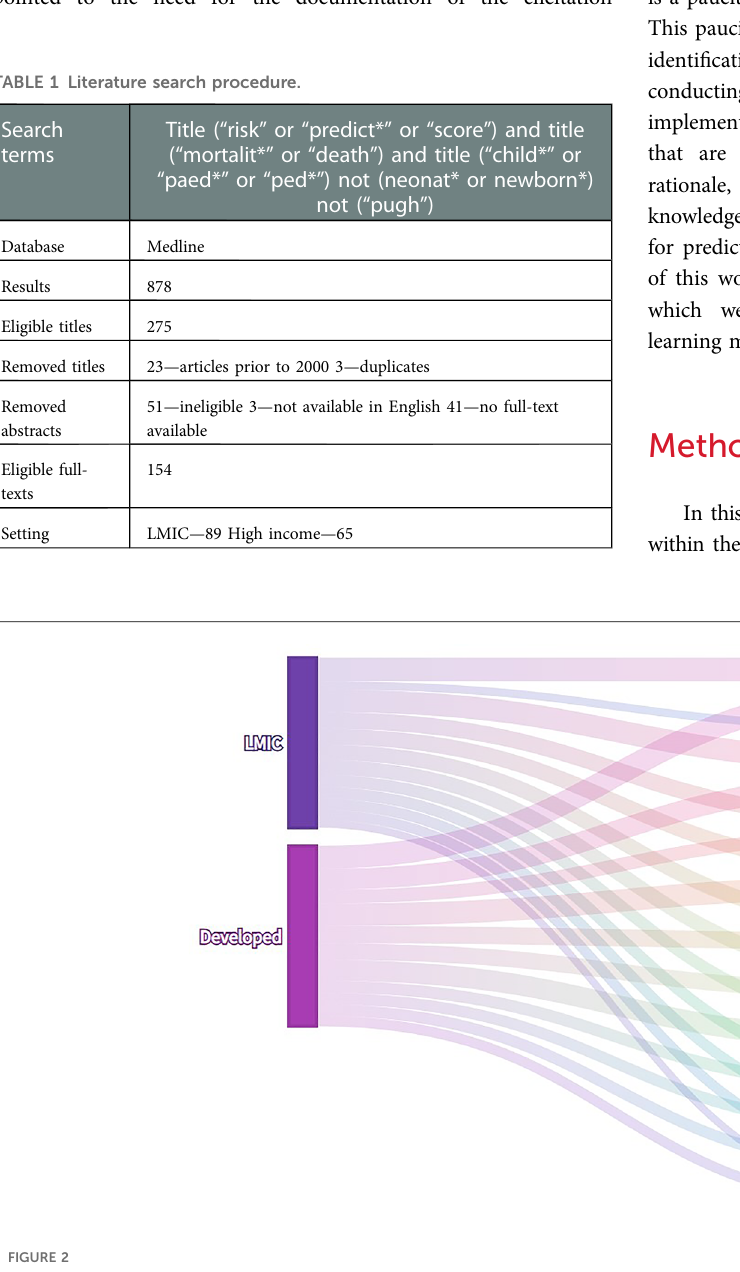
FIGURE 2 Alluvial diagram of literature search results — frequency with which clinical features are reported as risk factors for mortality in hospitalised children. Where features were present in existing predictive models, each feature was recorded as one instance. No laboratory data or special investigations except capillary blood glucose were included in analysis. Features present in more than 15% of publications are included in this visualization.